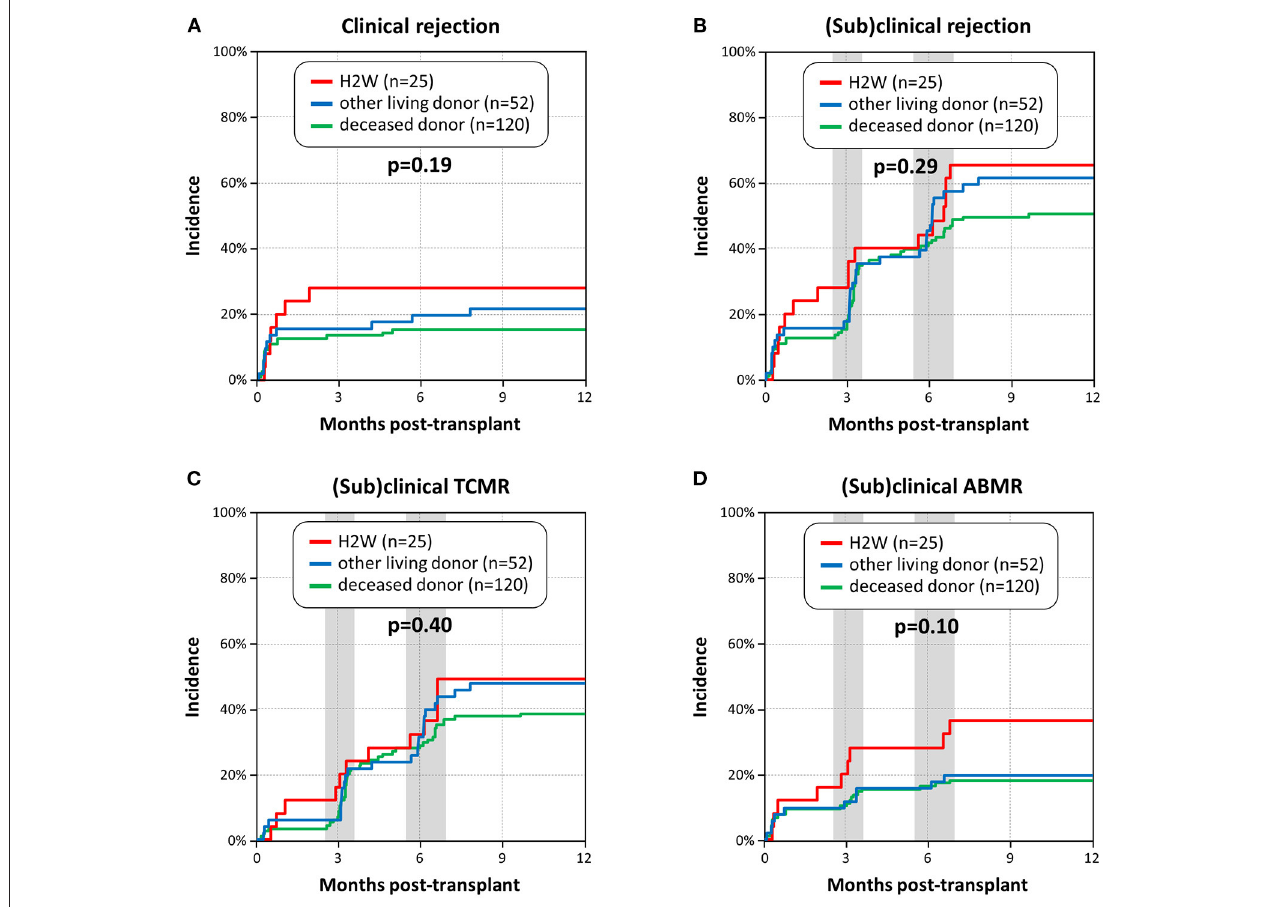
FIGURE 2 | Incidence of rejection within the first year post-transplant. (A) Incidence of clinical rejection. (B) Incidence of (sub)clinical rejection. (C) Incidence of (sub)clinical T cell-mediated rejection (TCMR). (D) Incidence of (sub)clinical antibody-mediated rejection (ABMR), including mixed rejection. The gray background areas represent the two time frames, in which surveillance biopsies at 3 and 6 months were